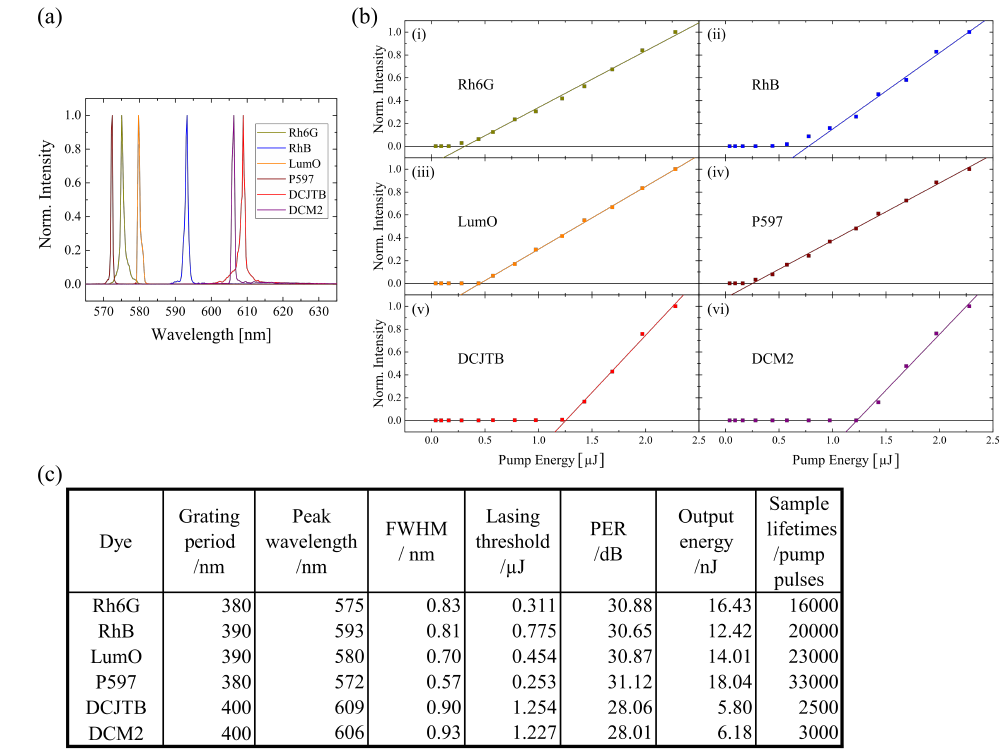
Figure 5. Six different organic dyes were found to be good dopants for PMMA. ( a ) The lasing spectra and ( b ) the lasing threshold of the respective dye-doped PMMA were measured. Meanwhile, an overview of the result was demonstrated in ( c ).